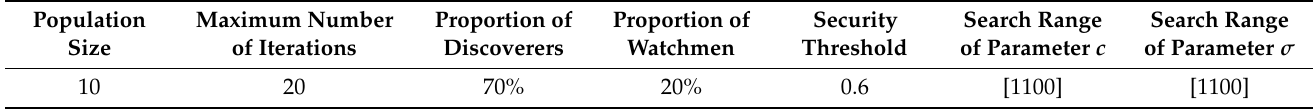
Table 4. Parameters of SSA.